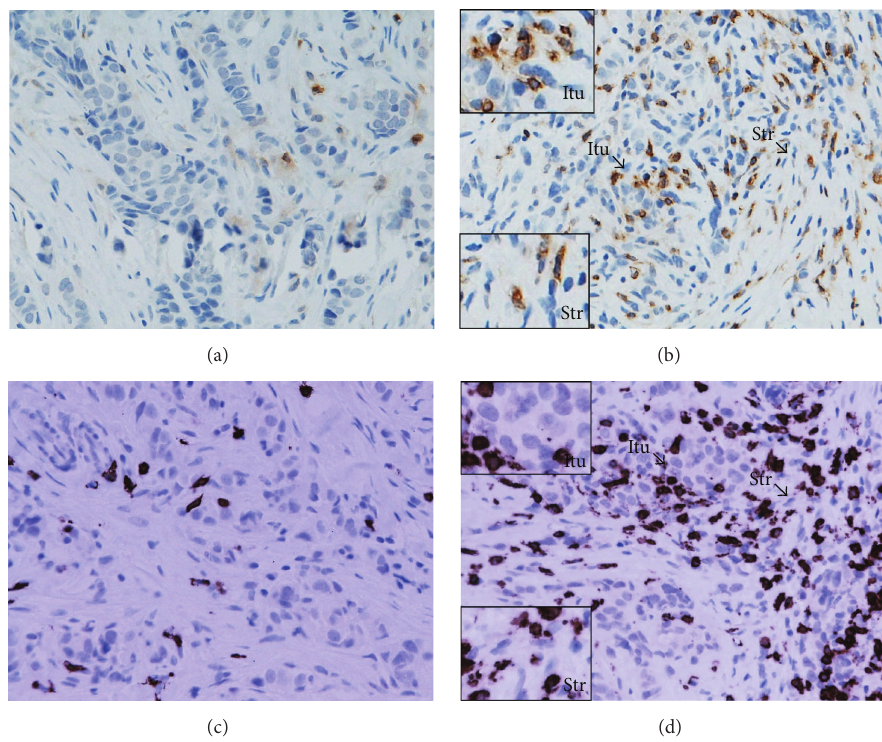
Figure 2: CD4 + (a, b) and CD8 + (c, d) T lymphocytes in the sections of LLABCs, using IHC staining, at 400x magnification. Briefly, heat- mediated antigen retrieval was performed using citrate buffer, pH 6 (20mins). The sections were then incubated with MAbs to CD4 (Dako, M7310) at a 1:80 dilution for 30 mins at RT and MAbs to CD8 (Dako, M7103) at a 1: 100 dilution for 30 mins at RT. Polymeric HRP-linker antibody conjugate was used as secondary antibody. DAB chromogen was used to visualize the staining. The sections were counterstained with haematoxylin. (a, c) Low level of CD4 + and CD8 + T cell infiltration; (b, d) high level of CD4 + and CD8 + T cell infiltration. The average number of brown membrane-stained cells, regardless of intensity, in contact with tumour cells or within tumour cell nests (Itu: intratumoural) and in the interstitial stroma (Str: stromal) per HPF was counted. Table 4: Correlations between tumour-infiltrating lymphocytes (TILs) and specific T cell subsets and grade of pathological response to NAC (1) (Spearman’s correlation coefficient (rho)) in women with LLABCs (2) . Grade of pathological response (3) Lymphocytes ( 𝑛 = 33 ) Groups Correlation coefficient 𝑝 value (2-tailed) Intratumoural infiltration